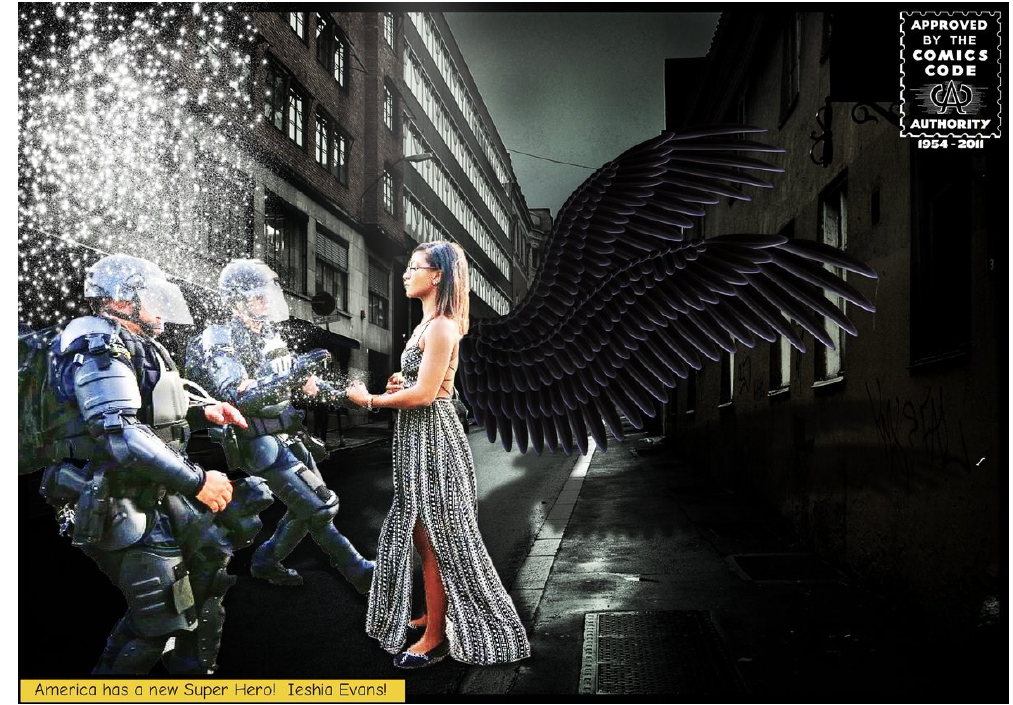
Figure 9. Ieshia Evans, superhero (2016). By Paul Brymer. Picture courtesy of the artist.